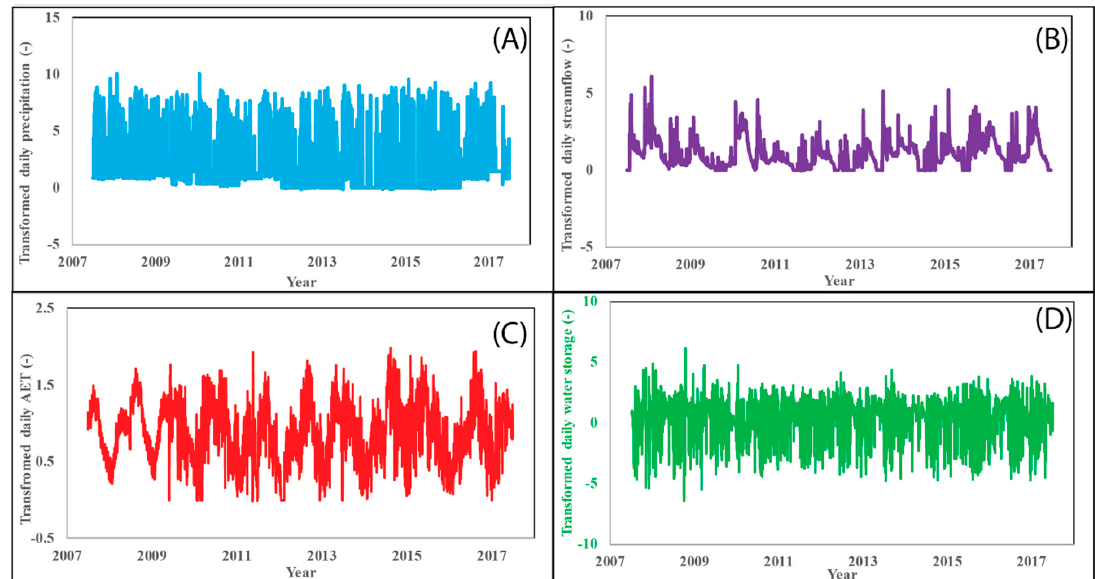
Figure 3. Transformed time series plots of catchment-scale daily precipitation ( A ), daily streamflow ( B ), daily actual evapotranspiration ( C ), and daily change in soil water storage ( D ) from water year 2008 through 2017. Note that the y-axis range is different in each plot to clearly show time series variability in hydrologic fluxes and soil water storage at MGC. Each time series is transformed using the arcsine hyperbolic transformation function or Equation (2).